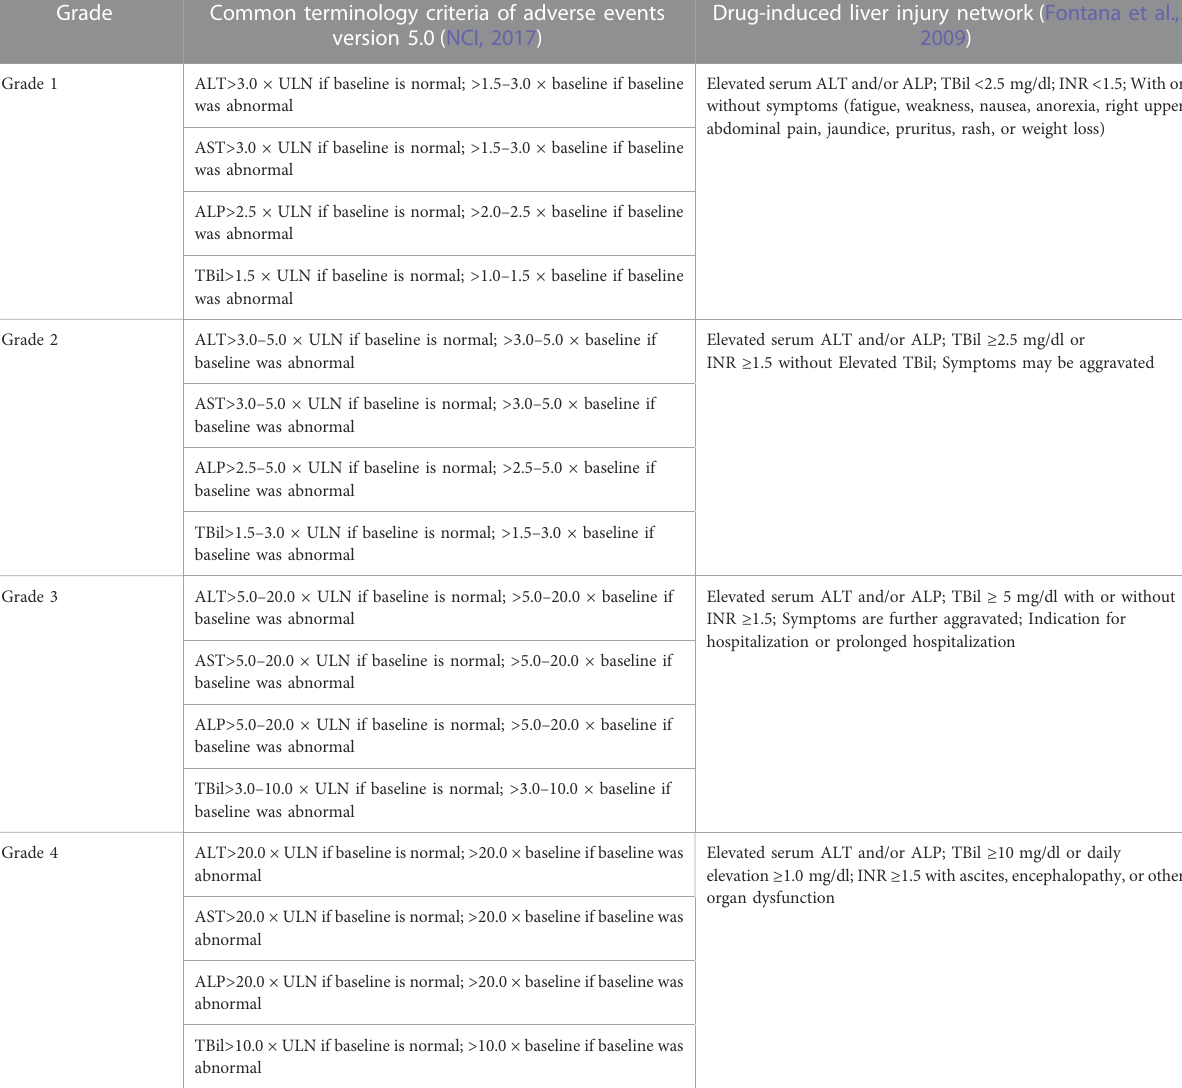
TABLE 4 Grading assessment of immune-mediated hepatitis by common terminology criteria of adverse events and drug-induced liver injury network. Grade Common terminology criteria of adverse events Drug-induced liver injury network (Fontana et al., version 5.0 (NCI, 2017)